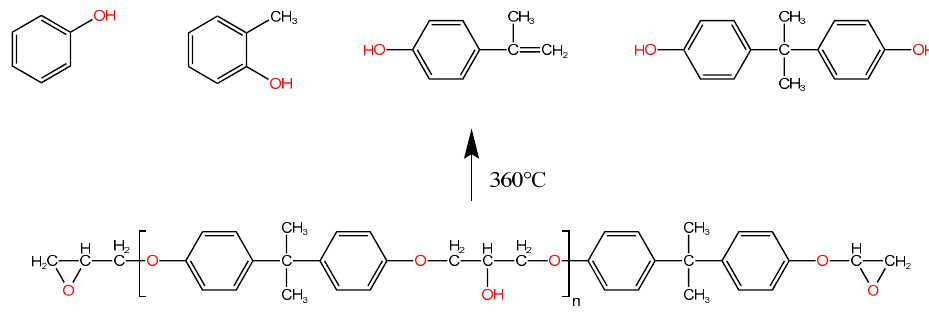
Figure 16. Schematic diagram of a thermal decomposition of EP.